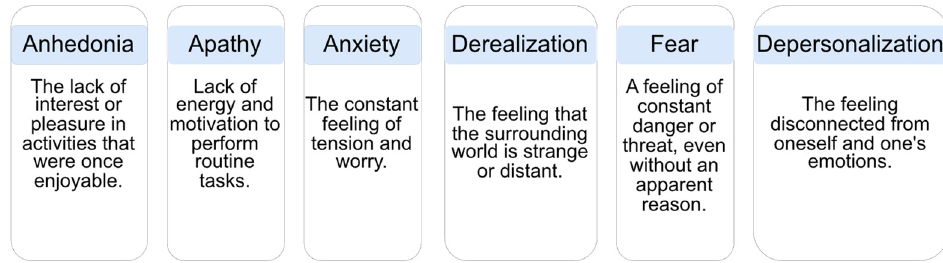
Figure 2. Emotions in schizophrenia.